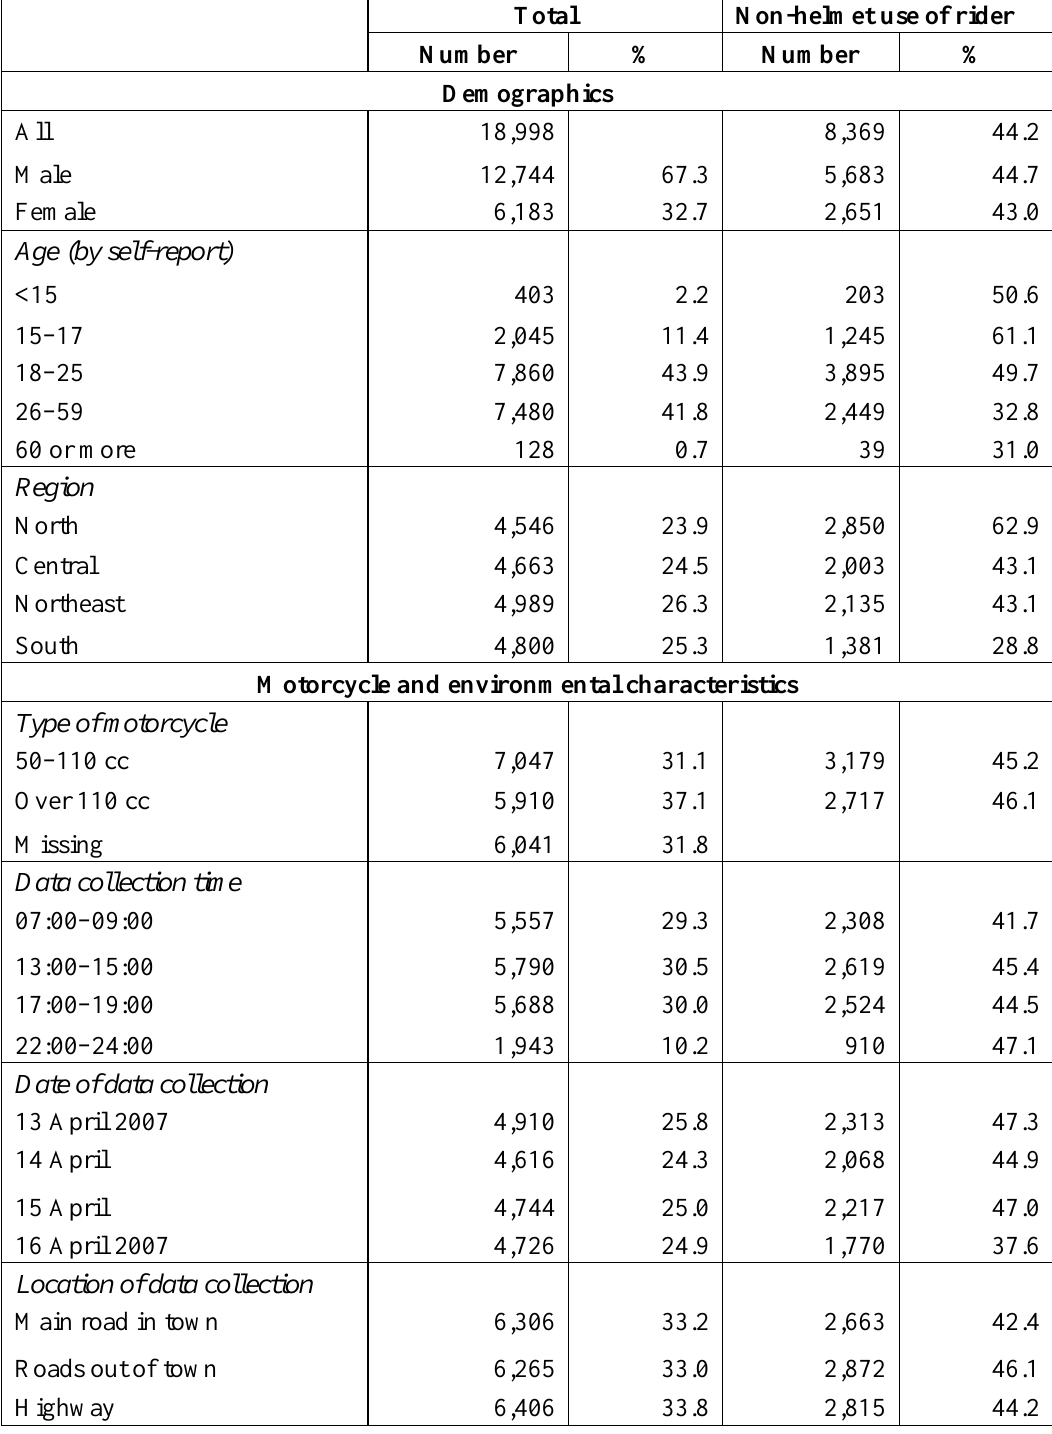
Table 1. Demographic, motorcycle and environmental sample characteristics of motorcyclists (during Songkran festival) (N =